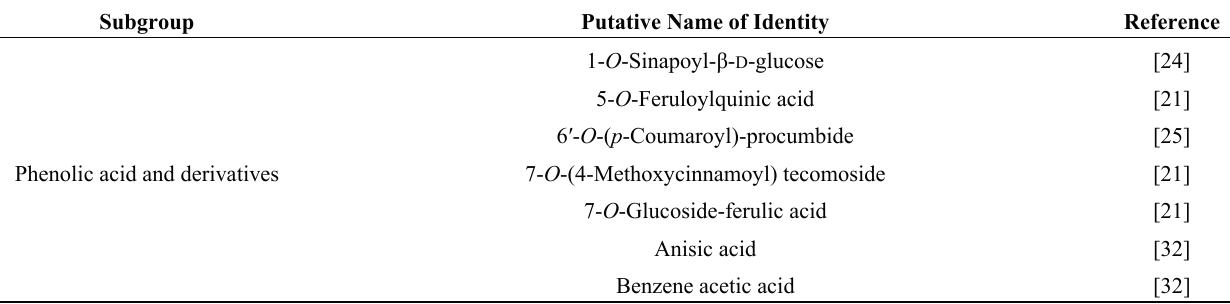
Table 3. Metabolites pinpointed for their potential contribution to FHB resistance and putatively assigned to non flavonoid phenylpropanoid